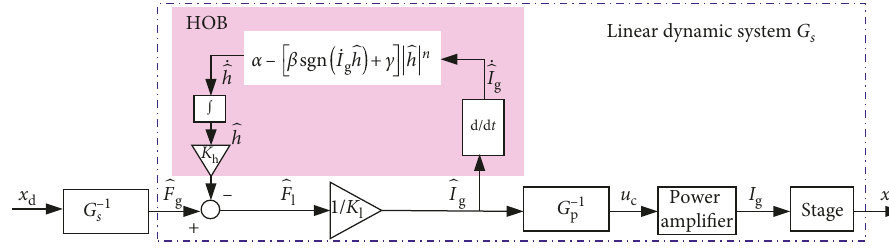
Figure 3: Scheme framework of the hysteresis compensation.